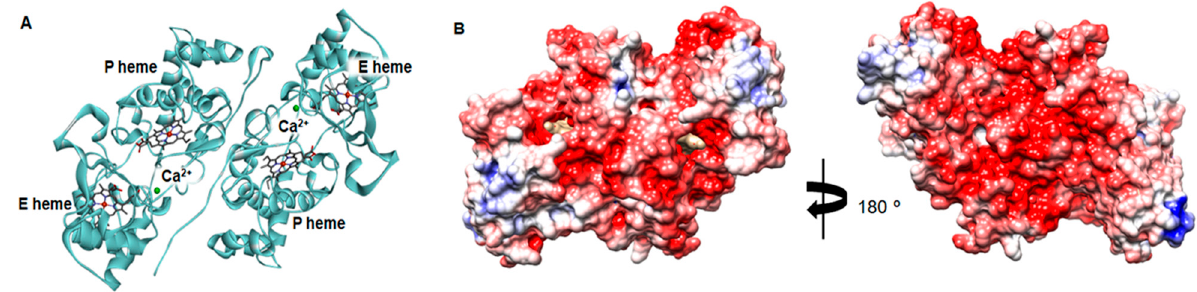
Figure 3. Structure of the mixed-valence Ng BCCP homodimer. In ( A ) is shown the dimer backbone, which comprises the asymmetric unit of the crystal, and in ( B ) its electrostatic surface potential is represented from − 5 to 5 KT/e (colored from negative red surface to positive blue surface). Panel ( A ) was prepared with BIOVIA Discovery Studio Visualizer 4.5 and Panel ( B ) with Chimera 1.10.2.